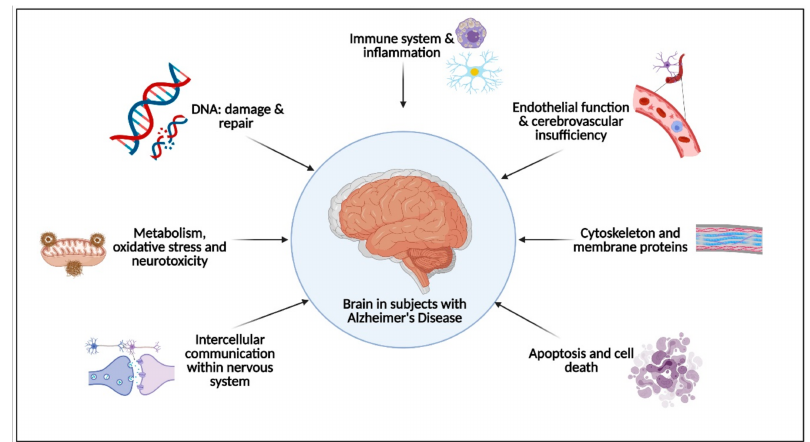
Figure 1. Alzheimer’s disease and related molecular pathways.